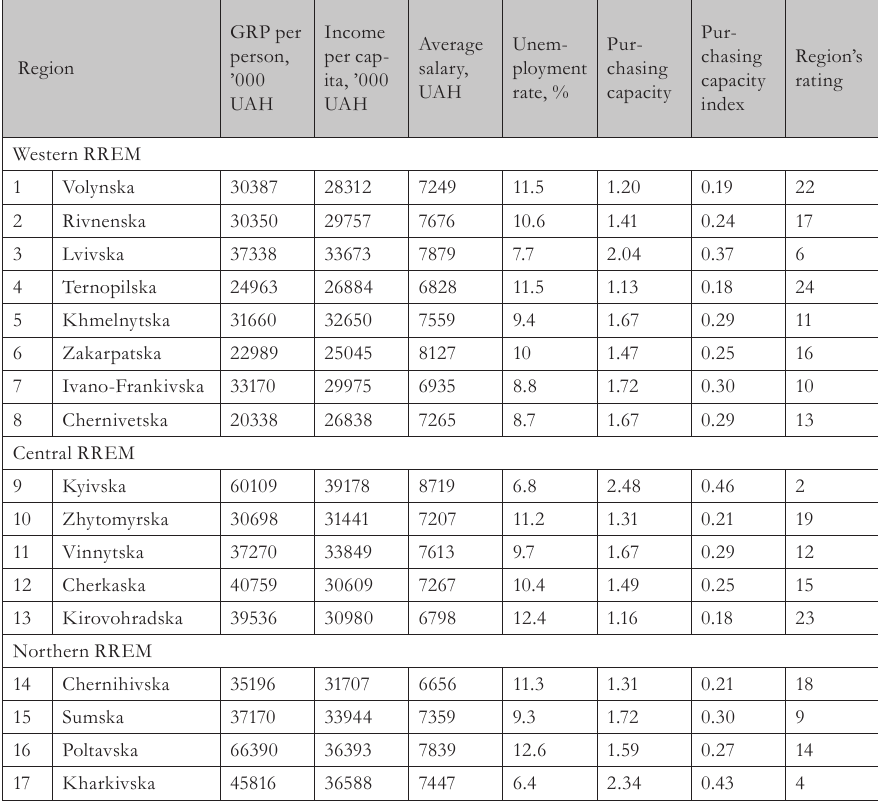
Tab. 5 – Purchasing power of citizens in Ukraine regions according to their division into RREM, on January 1, 2017, (excluding the temporarily occupied territory of the Autonomous Republic of Crimea, the city of Sevastopol and parts of the zone of the anti-terrorist opera- tion in Donetska and Luhanska regions). Source: Ministry of Justice of Ukraine. (2019), State Statistics Service of Ukraine